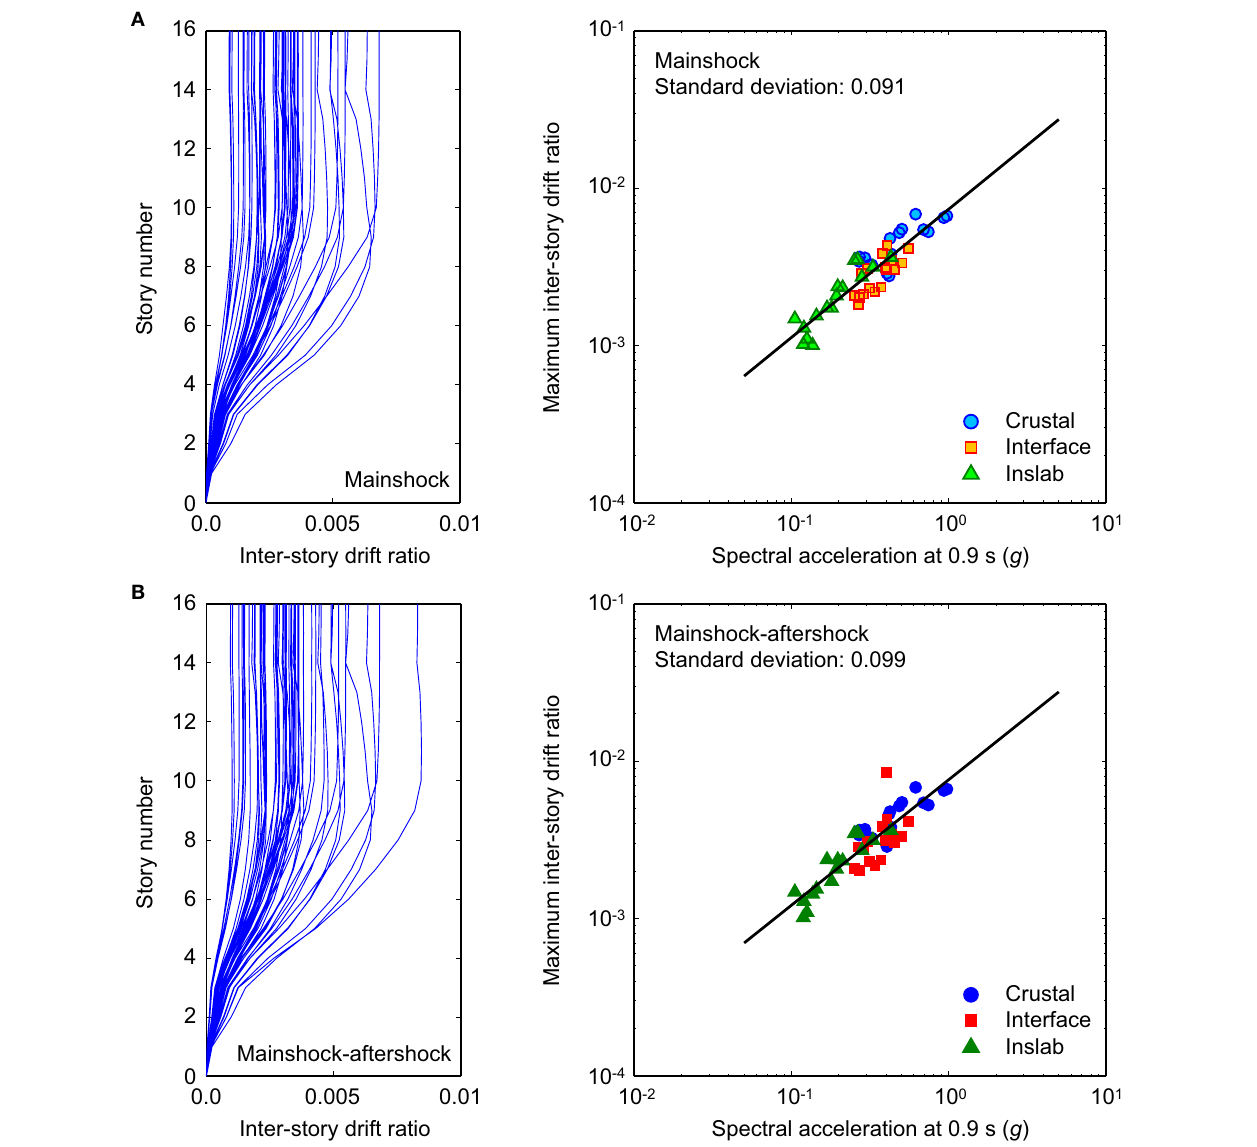
FIGURE 6 | Peak drift demands from cloud analysis displaying storywise profiles of interstory drift ratios and maximum interstory drift ratio and spectral acceleration relationships: (A) MS records and (B) mainshock–aftershock records .